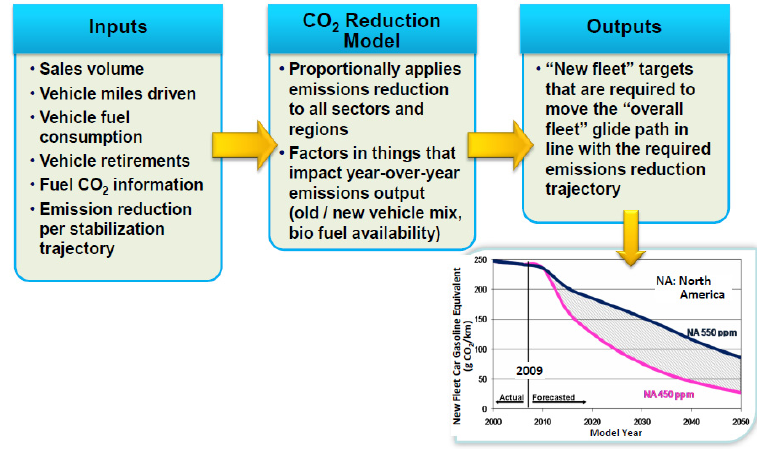
Figure 2. The CO 2 emissions reduction mode for Ford’s global vehicles. Source [34].